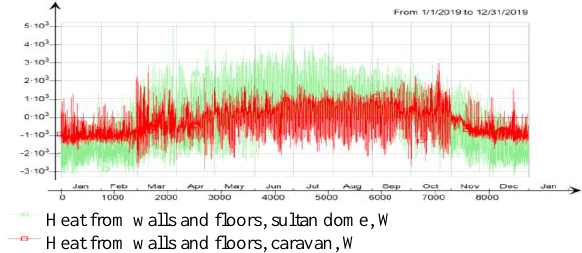
Figure 14. Heat from thermal mass,